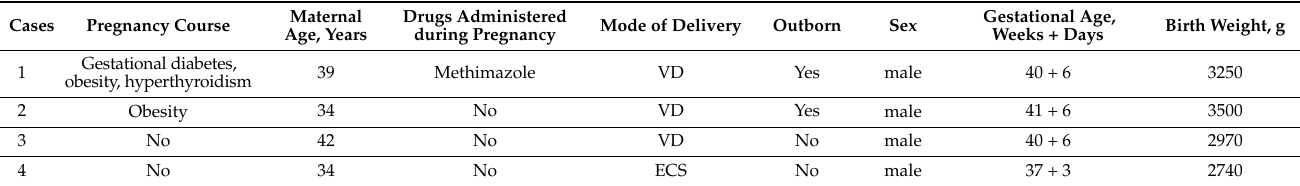
Table 1. Maternal and neonatal data of infants with SUPC who underwent